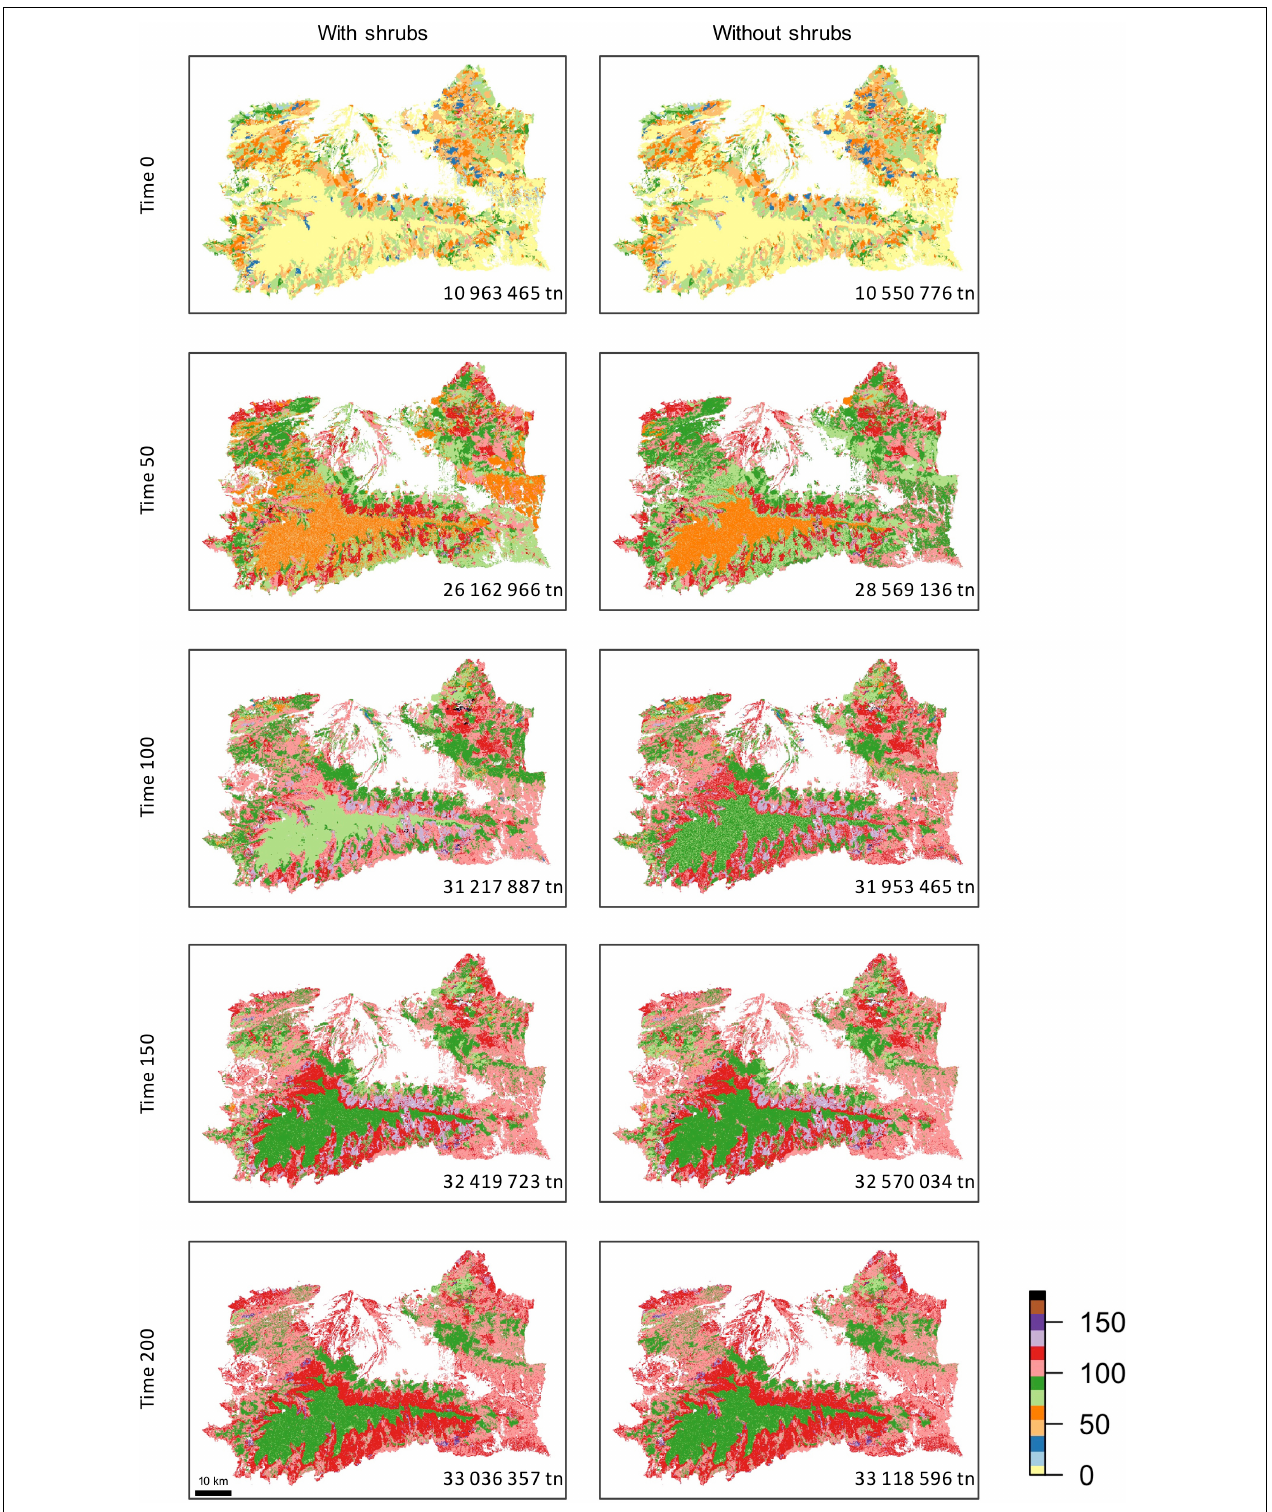
FIGURE 7 | Total aboveground biomass (tn ha-1) at years 0, 50, 100, 150, and 200 for the two simulations, as indicated in the scale bar on the right. Number in each panel indicates the total aboveground biomass (Tg) for the whole landscape at each time step.